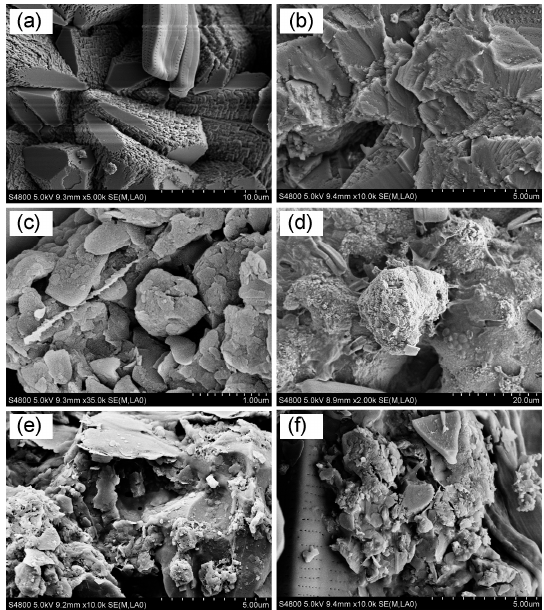
Figure 9. Scanning electron micrographs of CaCO 3 crystals with various sizes and shapes. ( a ) Well-formed rhombohedra in a cluster of calcite crystals, S PL ; ( b ) Sheet-like calcite crystals and their aggregates, S PS 2; ( c ) Finer spherulitic aggregates of calcites, S PS 1; ( d ) Clumps of calcite and aggregates, S PS 3; ( e ) Amorphous detritus and aggregations, S ABL ; ( f ) Detritic mineral grains and loose aggregations, S SZL .